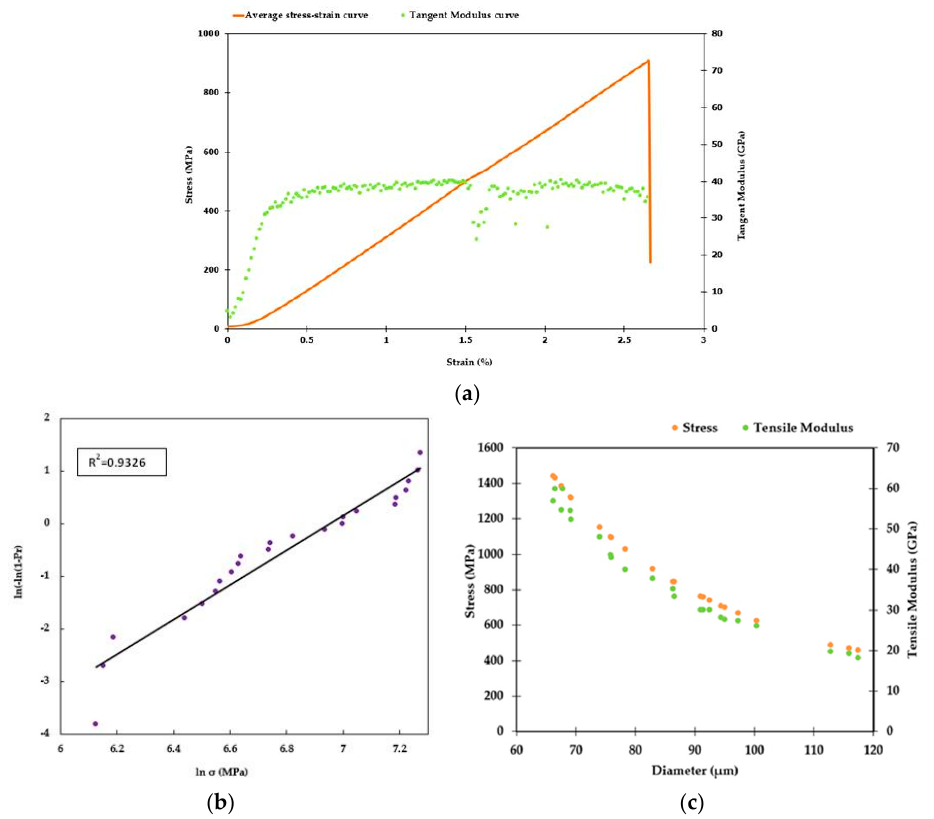
Figure 3. ( a ) Typical stress–strain curve and evolution of the tangent modulus. ( b ) Weibull distribution of stress at break. ( c ) Tensile modulus and stress at the break as a function of diameter measurement. Table 1. Weibull distribution parameters for plant